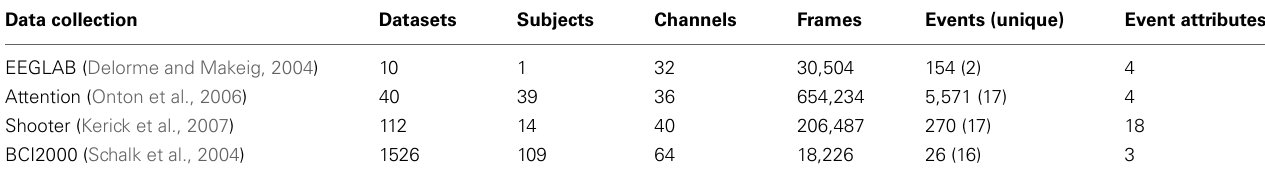
Table 2 | Attributes of test datasets (average number per